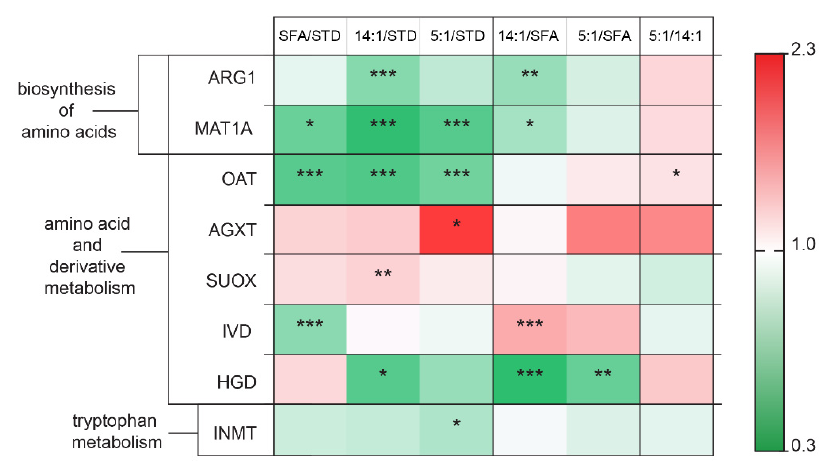
Figure 7. Changes in the abundance of proteins involved in amino acid metabolism. The statistically significant ( p < 0.05) value of the average intensity of the SFA, 14:1 and 5:1 groups compared to the STD group; the 14:1 and 5:1 groups com- pared to the SFA group; the 5:1 group compared to the 14:1 group. The significance of differences estimated using the model (1). *— p < 0.05; **— p < 0.01; ***— p < 0.001.